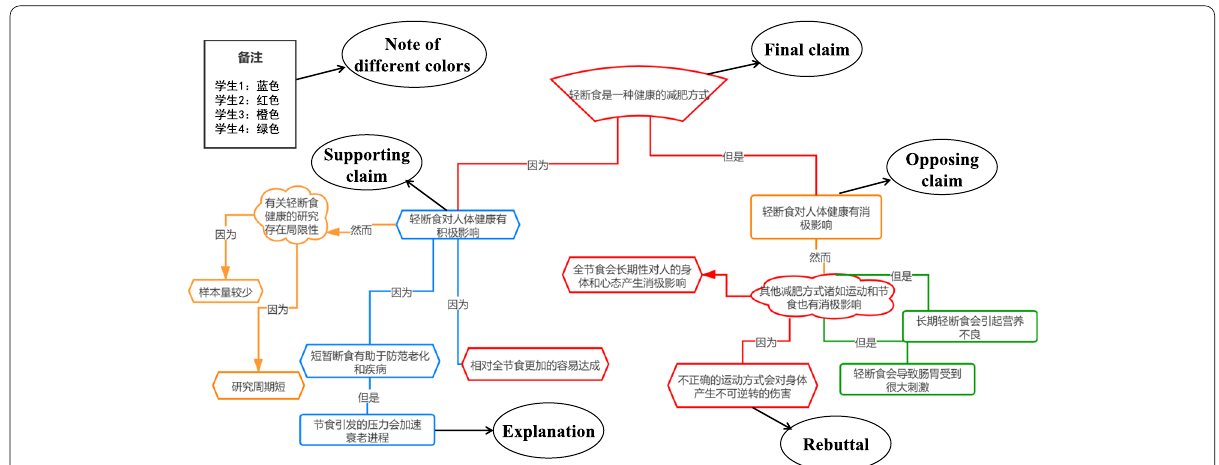
Fig. 2 Example of Argument